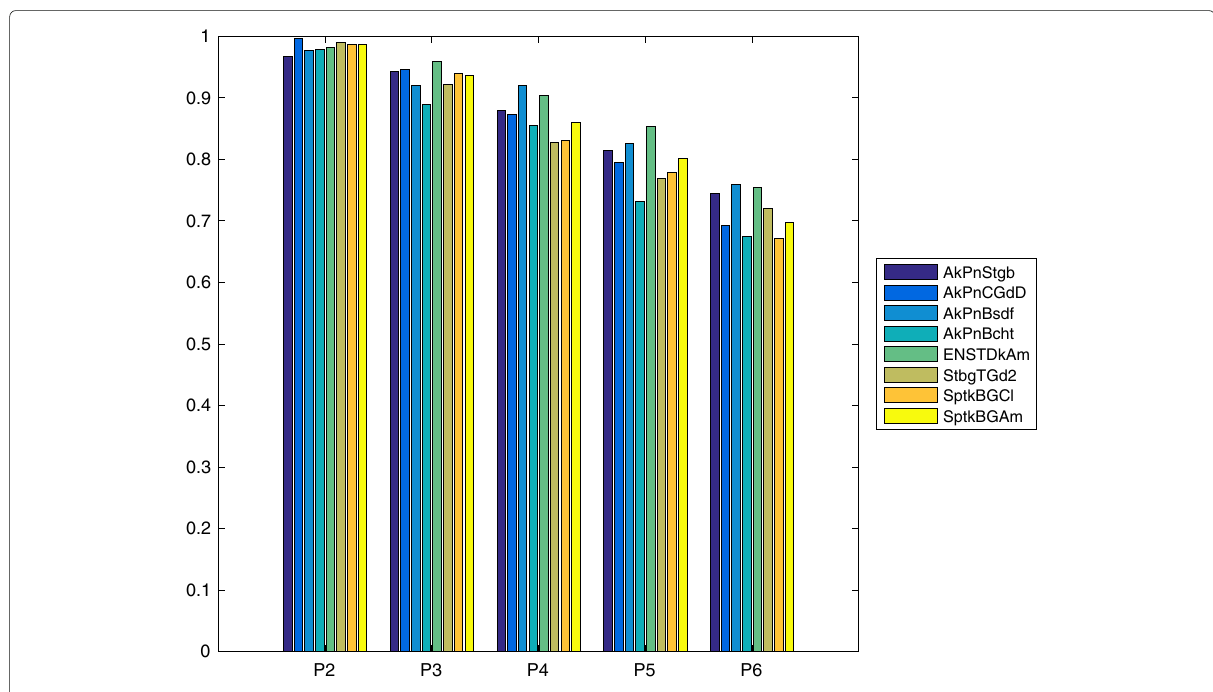
Fig. 12 Recall results of timbre robustness experiment